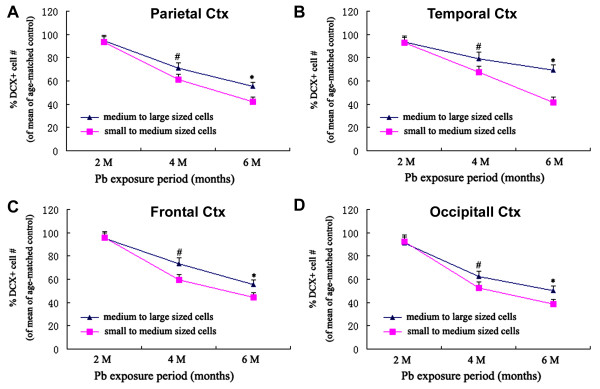
Line graphs showing the extent of reduction (% of control levels) of smaller (blue) relative to larger (purple) doublecortin-immunoreactive (DCX+) cells in Pb-treated guinea pigs over the parietal (A), temporal (B), frontal (C) and occipital (D) cortices surviving 2, 4 and 6 months. Statistic differences exist between of the two cell groups at 4 and 6 months surviving points in all analyzed areas. #: p<0.05; *: p<0.01.